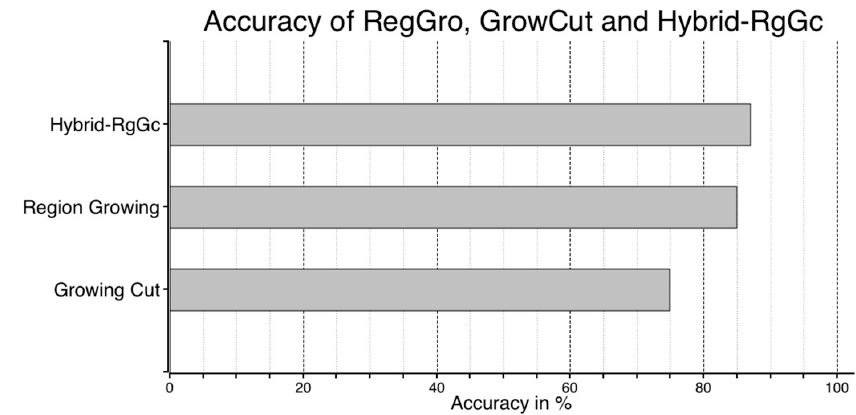
Images 110 – 150. The results of the flood-region segmentation, ground truth, and seed marker are partially shown in Figure 16. partially shown in Figure 16.